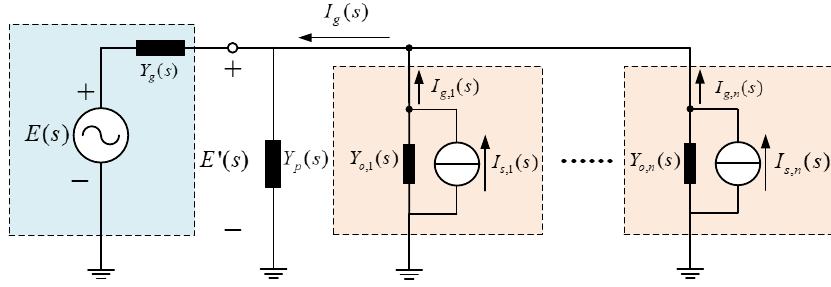
Figure 8. Admittance representation of a multi-parallel VSI grid-connected system.